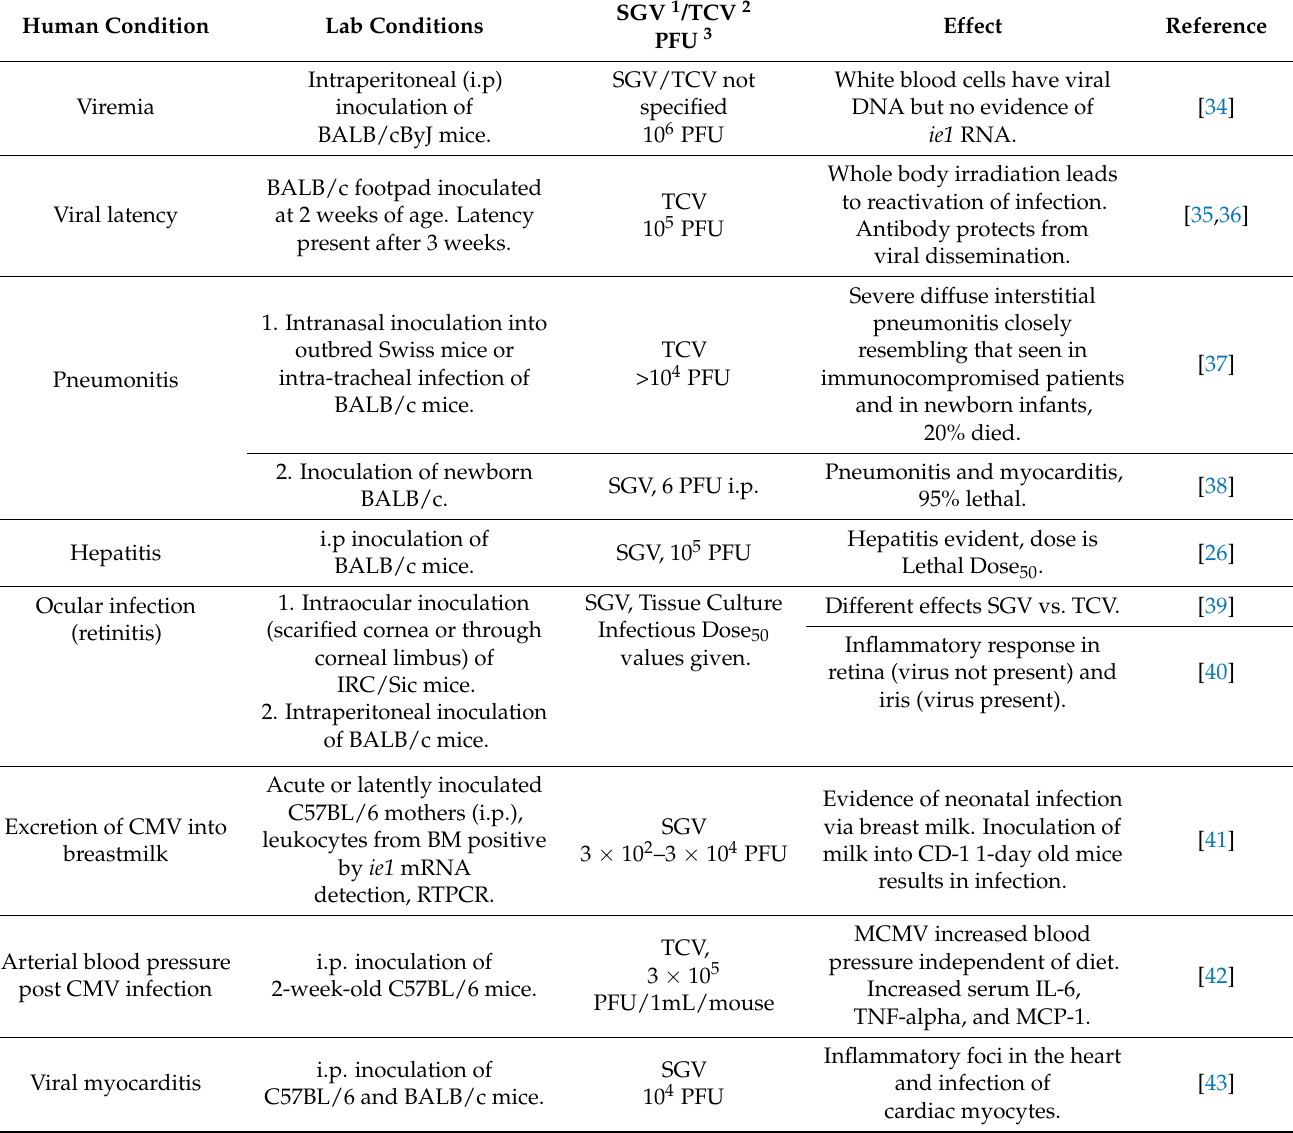
Table 1. Human disease caused by human cytomegalovirus (HCMV) modeled by murine cytomegalovirus (MCMV) infection in